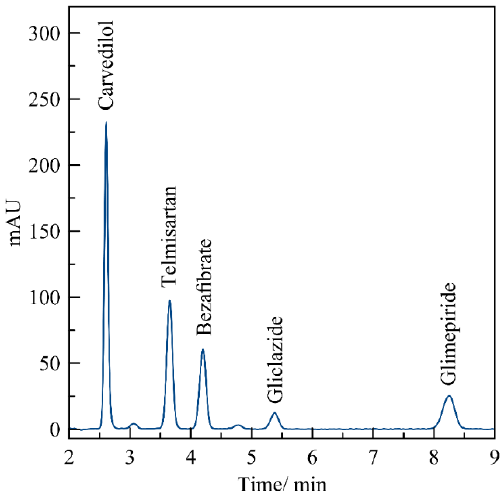
Figure 5. Chromatogram for the simultaneous determination of CVD, TEL, BZT, GZD, and GMP at 10 μg mL −1 from the five commercial pharmaceutical products. Conditions: stationary phase, C18 column, mobile phase acetonitrile: buffer phosphate, pH 3, (50/50 v / v ), isocratic flow rate 1 mL/min and 25